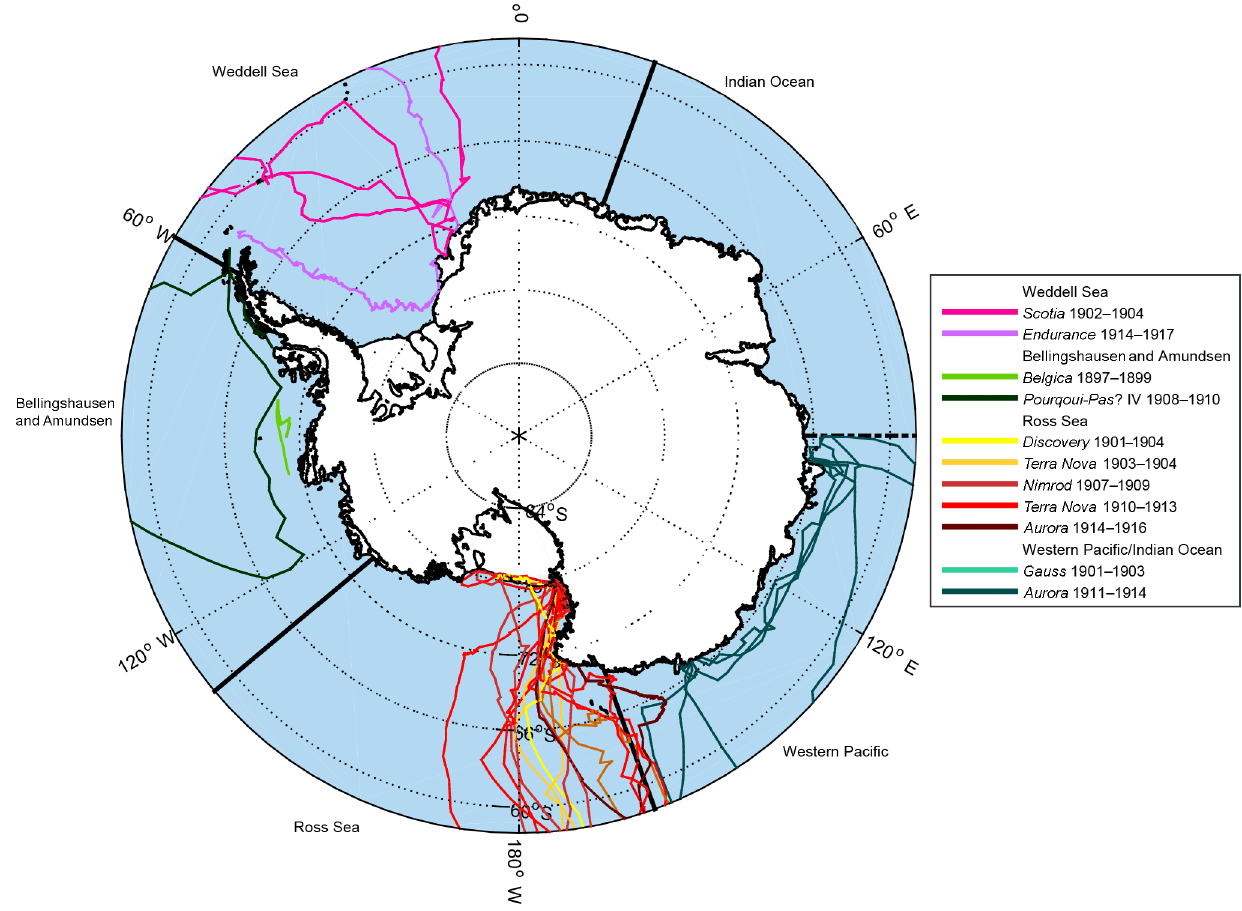
Figure 1. Map of expedition routes taken by ships used in this study. We only have coordinates for entry and departure of the pack ice for the 1901–1903 Gauss Expedition (Indian